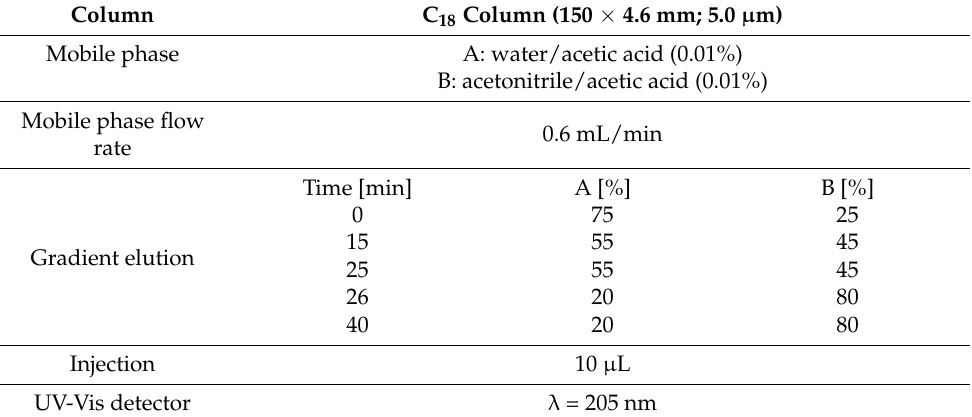
Table 7. Analysis conditions for plant extracts.